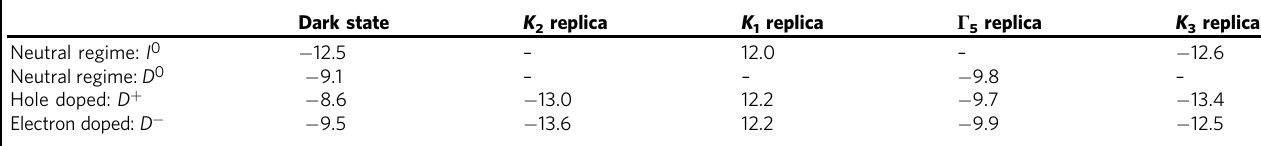
Table 1 Effective Landé g -factors of WSe 2 dark excitonic states and their phonon